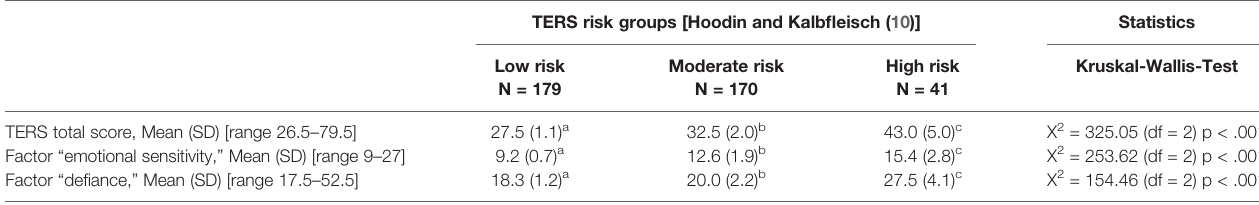
TABLE 4 | Comparison of TERS total score and subscales between risk groups.